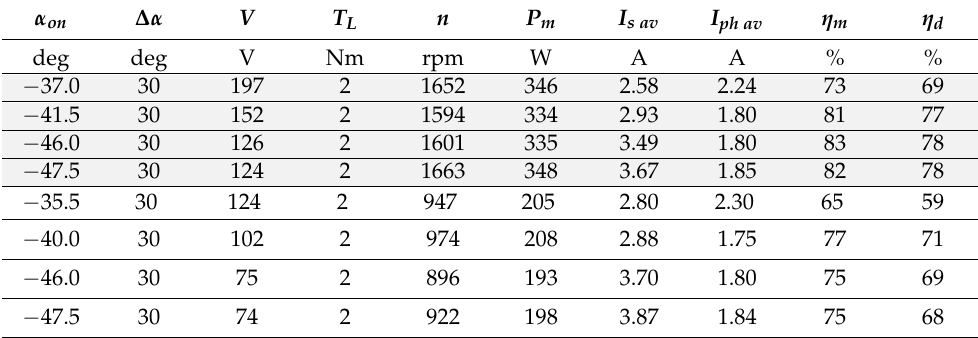
Table 2. Two examples of measurement results of the drive parameters obtained for similar operating points at different values of the control parameters.